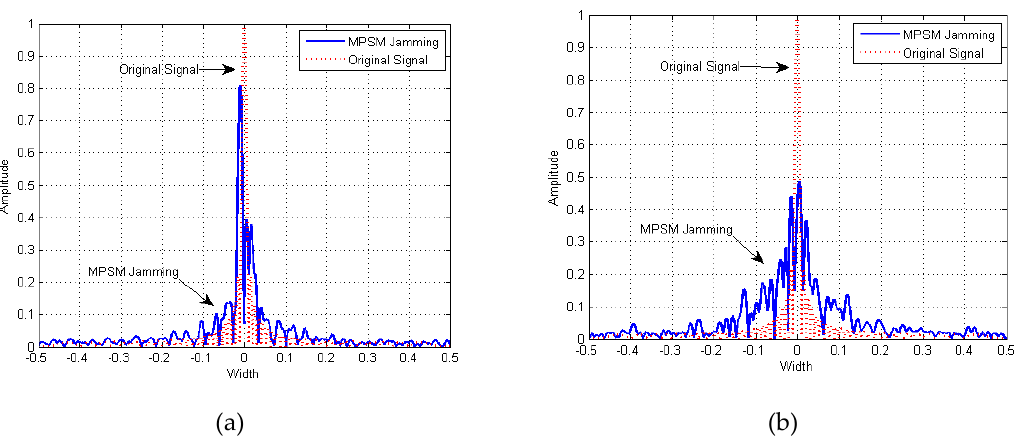
Figure 15. MPSM jamming with random section situation and phase situation: ( a ) 4 sections and ( b ) 16 sections.